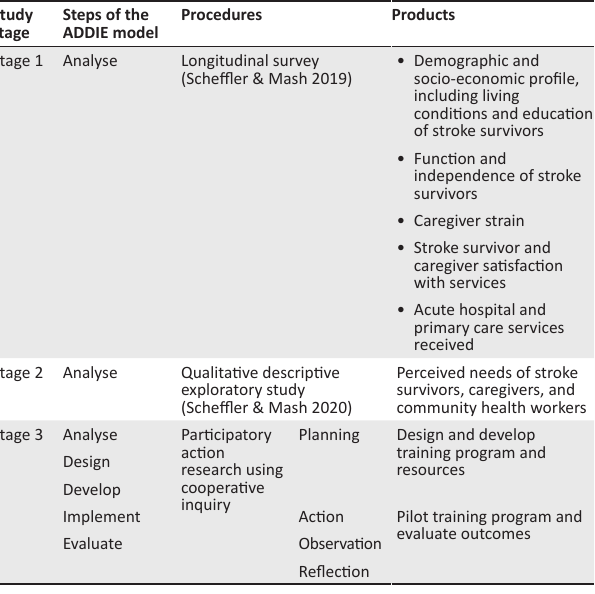
TABLE 1: Overview of the multistage study, procedures and results integrated with the steps of the ADDIE model. Study stage